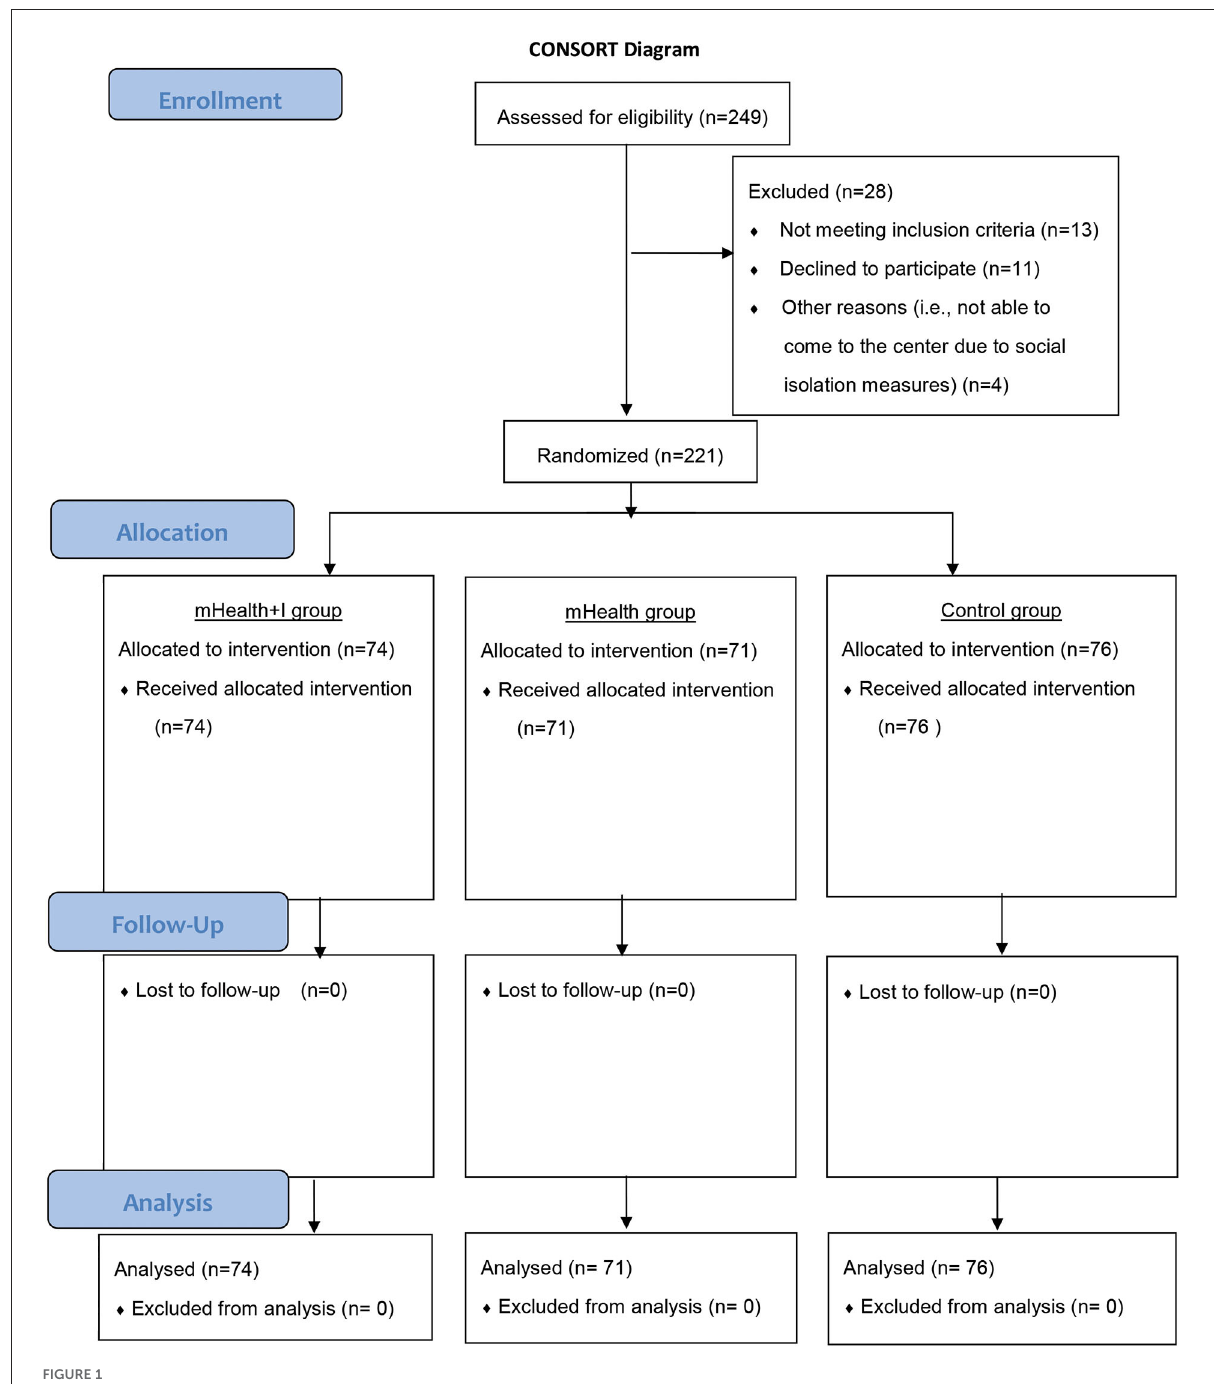
FIGURE1 CONSORT table.